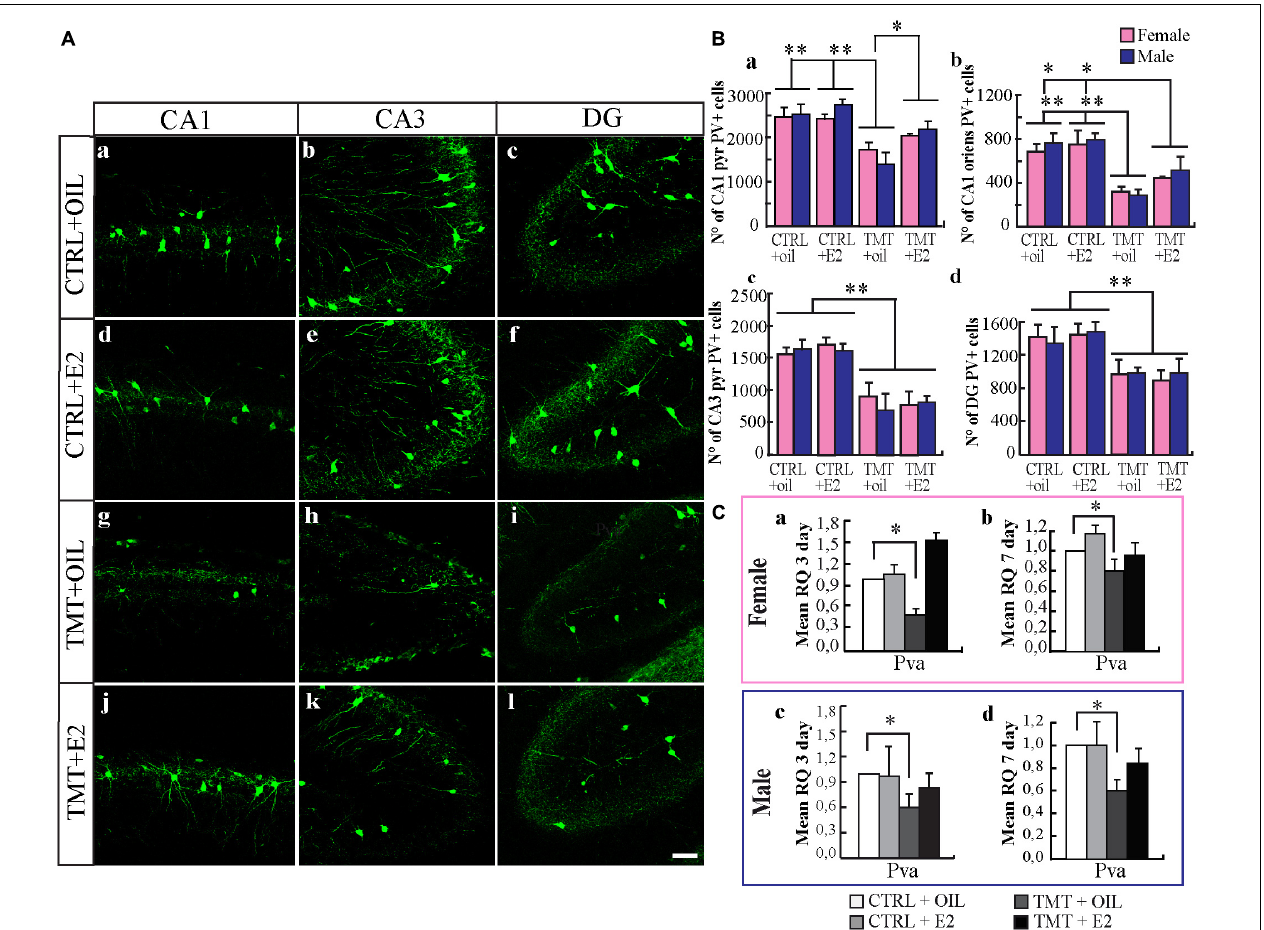
FIGURE 4 | (A) Distribution of parvalbumin (PV)-immunostaining in the CA1, CA3 regions and dentate gyrus (DG) of the different experimental groups. Representative micrographs of PV-stained hippocampal sagittal sections from CA1 (a,d,g,j) , CA3 (b,e,h,k) , and DG (c,f,i,l) hippocampal regions of CTRL+oil- (a–c) , CTRL+17 β -estradiol (E2)- (d–f) , TMT+oil- (g–i) and TMT+E2- (j–l) treated rats. A lower number of PV-IR cells is detectable in the CA1 and CA3 pyramidal layer of TMT+oil-treated rats compared with both control groups; conversely TMT+E2-treated rats exhibit a number of PV-IR cells comparable to those of CTRL+oil groups. Scale bar: 100 µ m. (B) Numbers of PV-IR neurons in different hippocampal subfields of the different experimental groups. Stereological cell counts performed in the CA1 pyramidal layer, followed by three-way ANOVA revealed a significant effect of TMT treatment ( F 1 , 29 = 37.43 p < 0.001) and E2 administration ( F 1 , 29 = 6.95 p < 0.05); TMT ∗ E2 interaction was also significant ( F 1 , 29 = 4.53 p < 0.05). No significant difference related to sex was detectable ( F 1 , 29 = 0.26, p > 0.05). Tukey post hoc test showed a significant decrease in the number of PV-positive cells in the TMT+oil-treated groups (M-TMT+oil and F-TMT+oil) compared with CTRL groups (CTRL+oil and CTRL+E2) ( p < 0.001) (a) . Both F- and M- TMT+E2-treated groups exhibited a number of PV-positive cells comparable to those of CTRL groups (Tukey post hoc test p > 0.05) and significantly higher than TMT+oil-treated groups (Tukey post hoc test p < 0.05) (a) . In the CA1 stratum oriens (b) , CA3 pyramidal layer (c) , and DG (d) , TMT administration induced an overall reduction of PV-immunoreactive cells, as pointed out by three-way ANOVA, which revealed a significant effect of TMT treatment (CA1 stratum oriens : TMT F 1 , 29 = 55.17; CA3 pyramidal layer: TMT F 1 , 29 = 52.69; DG: TMT F 1 , 29 = 17.1; Tukey post hoc test